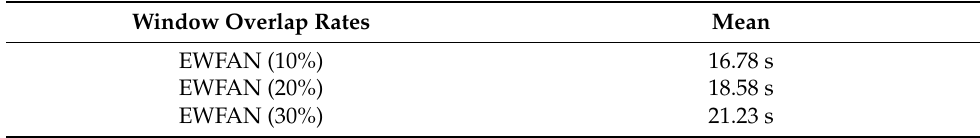
Table 4. Comparison of aircraft inspection time with different window overlap